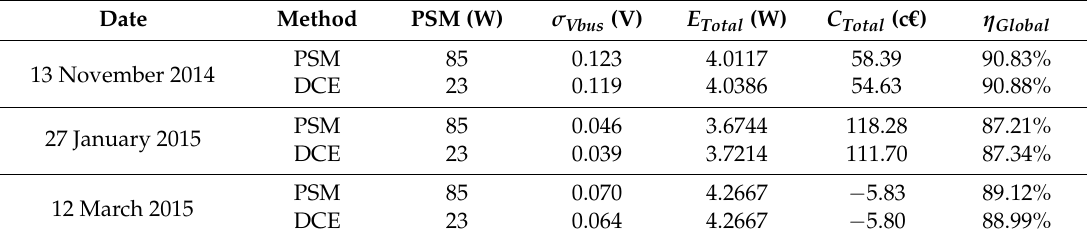
Table 3. Comparison of the last two methods for the three considered days.